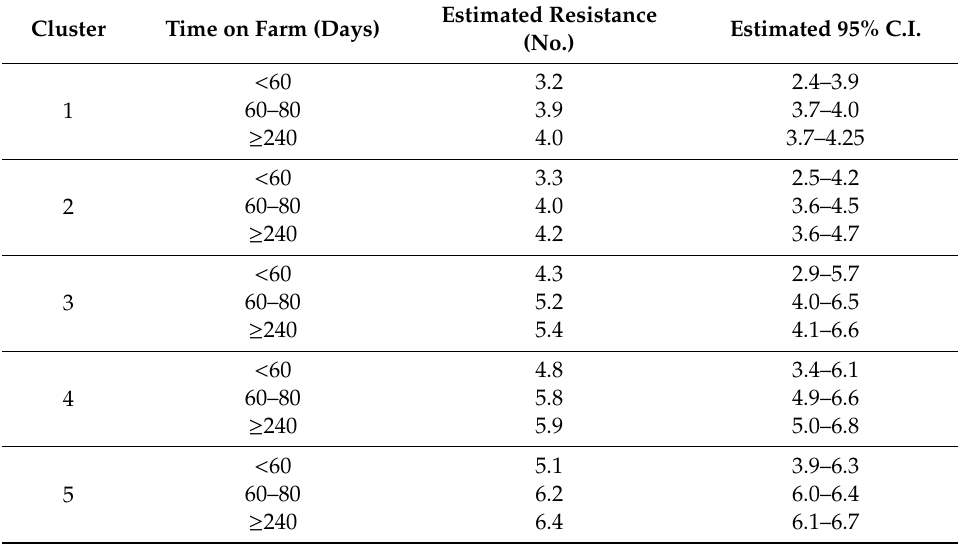
Table 5. Predicted counts of resistance by the clusters and time on farm of the categories. Cluster